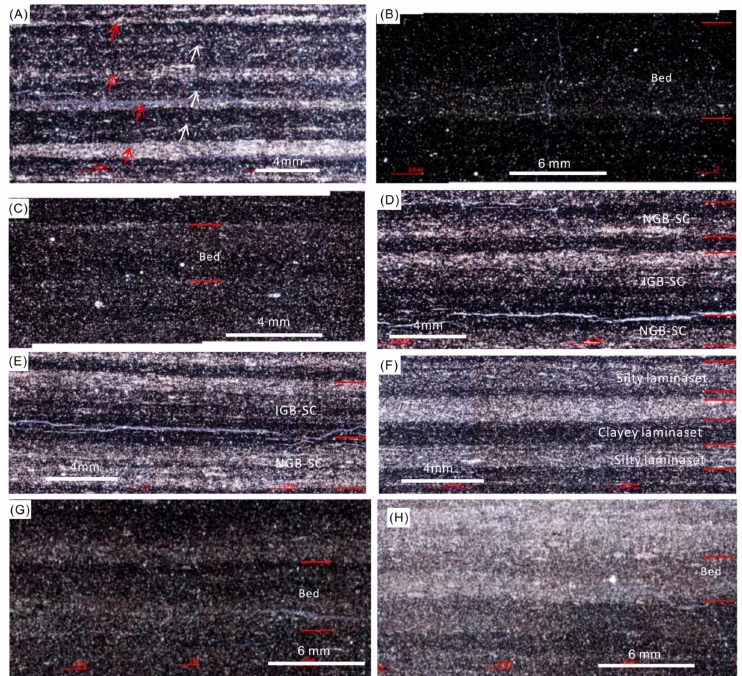
Figure 4. Standard thin section photos showing typical characteristics of laminae, laminasets, and beds. ( A ) Clayey and silty laminae. Red arrows point to silty laminae, which are mainly composed of siltstone and have brighter color. White arrows point to clayey laminae, which consist mainly of claystone and have dark gray color. Samples were collected in the Longmaxi Formation of the Shuanghe outcrop (sample number: 9-15-1); ( B ) NGB-C, with a continuous, planar base boundary and an abrupt contact with underlying units, is mainly composed of clayey laminae. From the base to the top, the grain size gradually becomes finer and the color becomes grayer. Samples were collected from the Wufeng Formation at the Shuanghe outcrop (sample number: 4-20-1); ( C ) IGB-C, with a continuous, planar top boundary and an abrupt contact with overlying units, are mainly composed of clayey laminae as well. From the base to the top, the grain size gradually becomes coarser and the color becomes brighter. Samples were collected from the Wufeng Formation at the Shuanghe outcrop (sample number: 4-37-1); ( D , E ) NGB-SC and IGB-SC. NGB-SC, with sharp, continuous, and plana base, has silty laminasets at the base that grade into clayey laminasets at the top. IGB-SC, with sharp, continuous, and wavy top, has clayey laminasets at the base that grade into silty laminasets at the top. Samples were collected from the Longmaxi Formation of the Shuanghe outcrop (sample numbers are 9-2-1 and 9-3-1, respectively); ( F ) Silty and clayey laminasets. Silty laminaset consists of silty laminae intercalated with thin lenticular and discontinuous clayey laminae. Clayey laminaset consists of clayey laminae intercalated with lenticular and discontinuous silty laminae. Samples were collected from the Longmaxi Formation of the Shuanghe outcrop (sample number: 9-15-2); ( G ) NGB-C, with a continuous, planar base boundary and an abrupt contact with underlying units, is mainly composed of clayey laminae. From the base to the top, the grain size gradually becomes finer and the color becomes grayer. Samples were collected from the Wufeng Formation at the Shuanghe outcrop (sample number: 4-8-1); and ( H ) NGB-C, with a continuous, wavy base boundary and an abrupt contact with underlying units, is mainly composed of clayey laminae. From the base to the top, the grain size gradually becomes finer and the color becomes grayer. Samples were collected from the Wufeng Formation at the Shuanghe outcrop (sample number: 4-14-1). Abbreviations are shown in Table